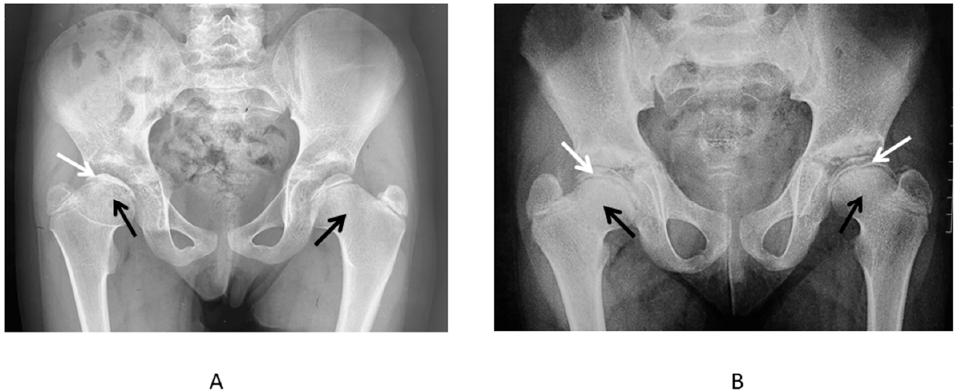
Figure 5. Advanced radiological changes in the hip joints of the patients with MED type 4. ( A ) Anteroposterior radiograph of the hips of the 9-year-old patient: abnormal shape and structure of the epiphyses of the femoral heads—half-moon shape and density resembling that of Perthes disease on the right side (white arrow), shortening of the femoral necks more prominent on the right side (black arrows). ( B ) Anteroposterior radiograph of the hips of the 11-year-old patient: abnormal shape of the epiphyses of the femoral heads—half-moon shape (white arrows), shortening of the femoral necks—the coxa breva (black arrows).